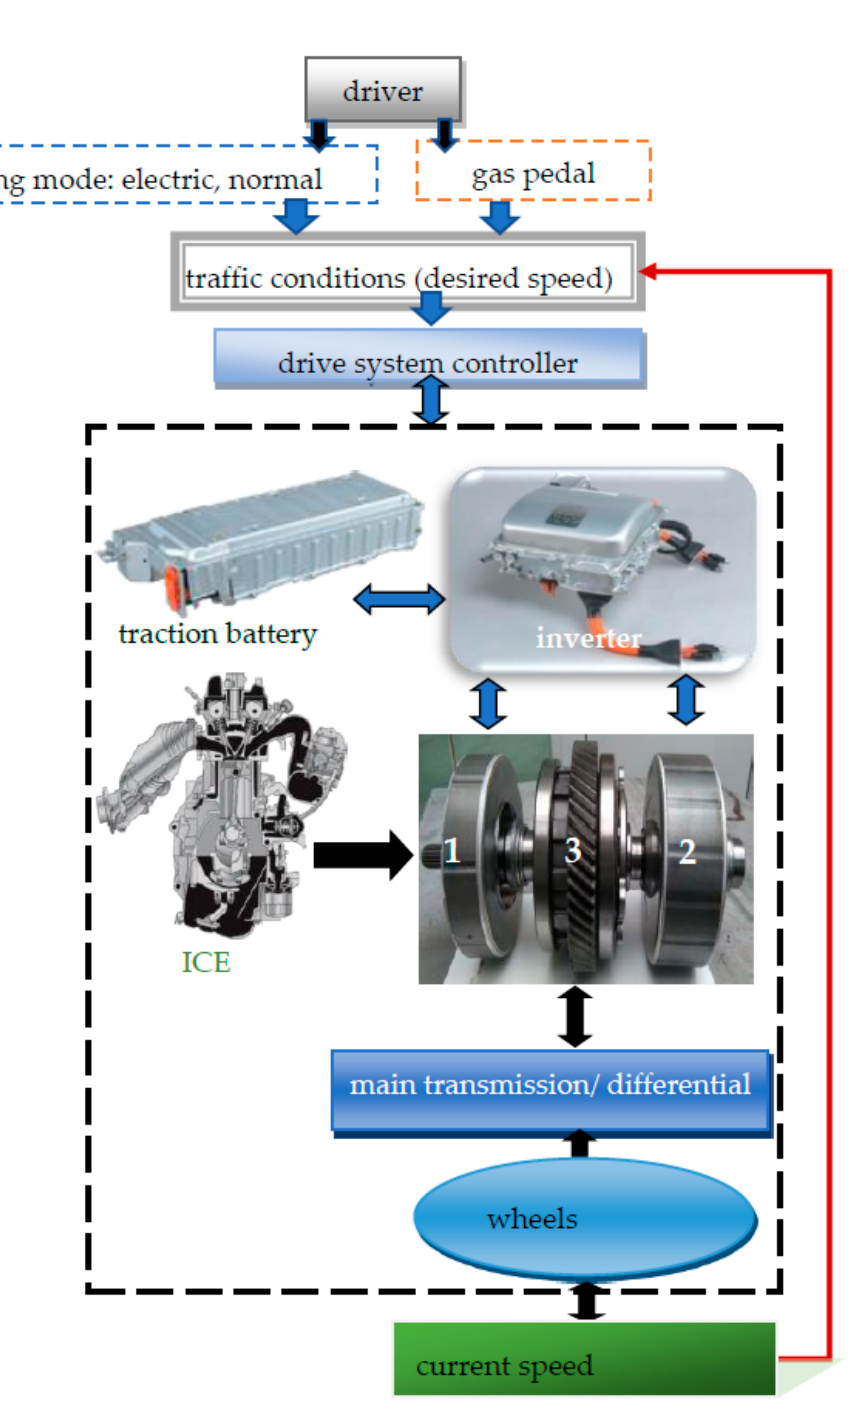
Figure 1. Construction of the power-split hybrid drive model: ICE—internal combustion engine, 1—generator (MG1), 2—electric motor (MG2), 3—planetary gear set.